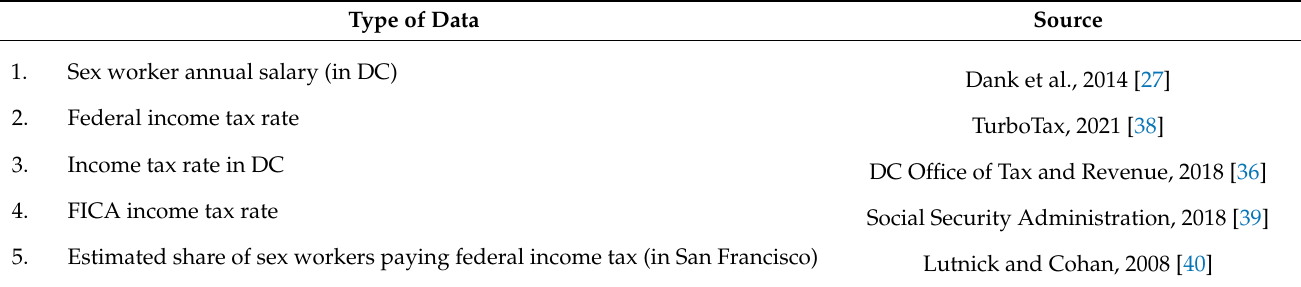
Table 7. Sources of data used to calculate income tax generated following